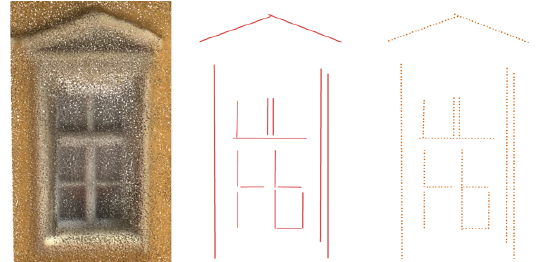
Figure 3. 2D edges generated with Edison edge detection algorithm and given as input to EdgeGraph3D (left), and their respective matched segments using EdgeGraph3D (right).